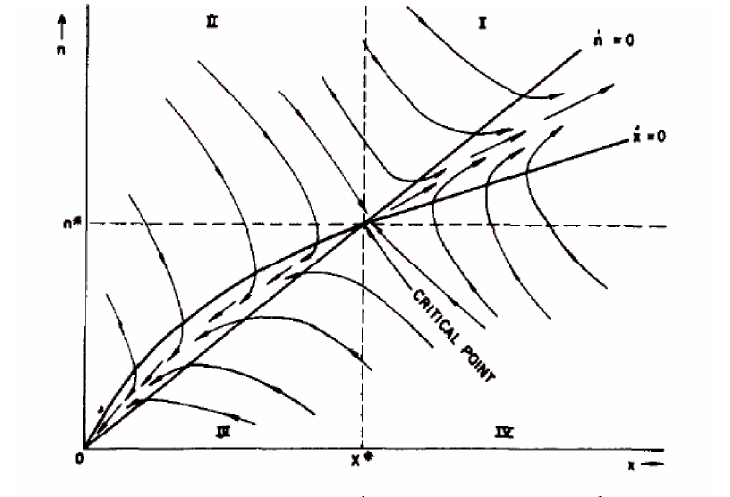
Figure 1. Example of phase portrait of solute atoms in precipitates (x) and vacancies (n) calculated under irradiation. Reprinted with permission from Ref. [19]. Copyright 1977 Elsevier. At large time, the system can reach two distinct attractors: a stable node (0,0) and a the saddle critical point (x*,n*). The existence of these attractor partition the abstract x-n plane in four distinct quadrants. The arrows displays the velocities of the solute atoms and vacancies in each quadrant (I to